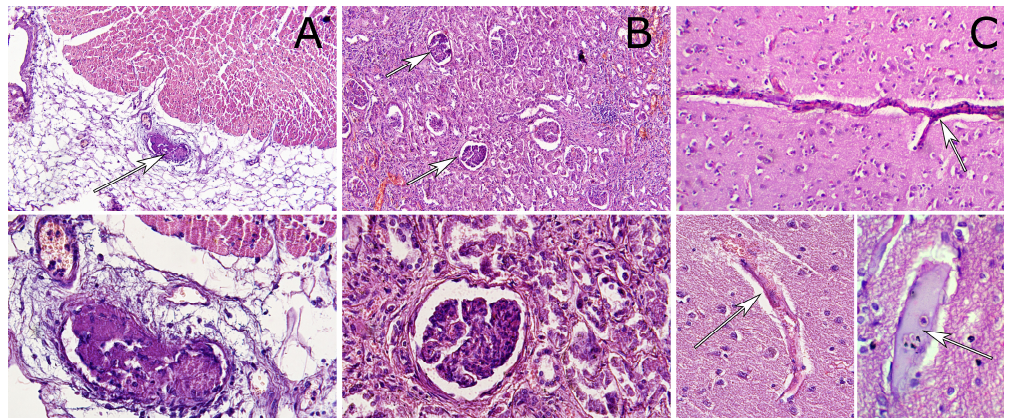
Figure 5. Human autopsy samples demonstrated basophilic DNA-rich clots in heart ( A ), kidney ( B ), and brain ( C ) tissues. H&E staining, Upper row—objective 10×, lower row—objective 40×. and brain ( C ) tissues. H&E staining, Upper row—objective 10 × , lower row—objective 40 ×